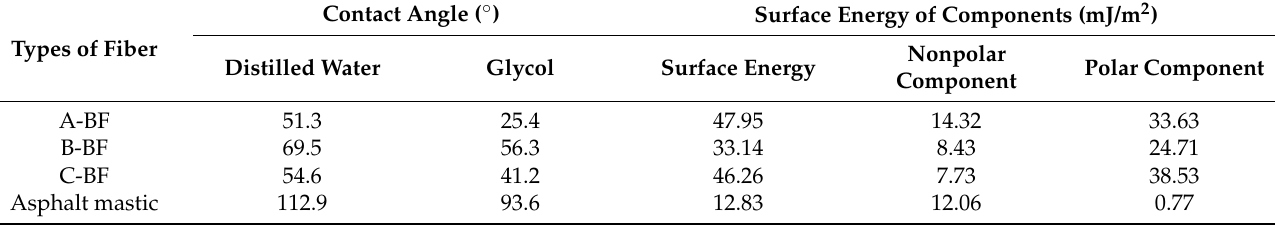
Table 4. Surface energy of BF and the asphalt mastic (25 ◦